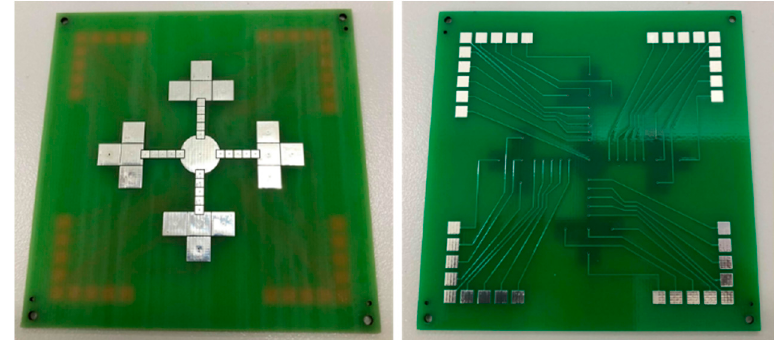
Figure 8. Double-layer electrode pattern fabricated by PTH-PCB method.